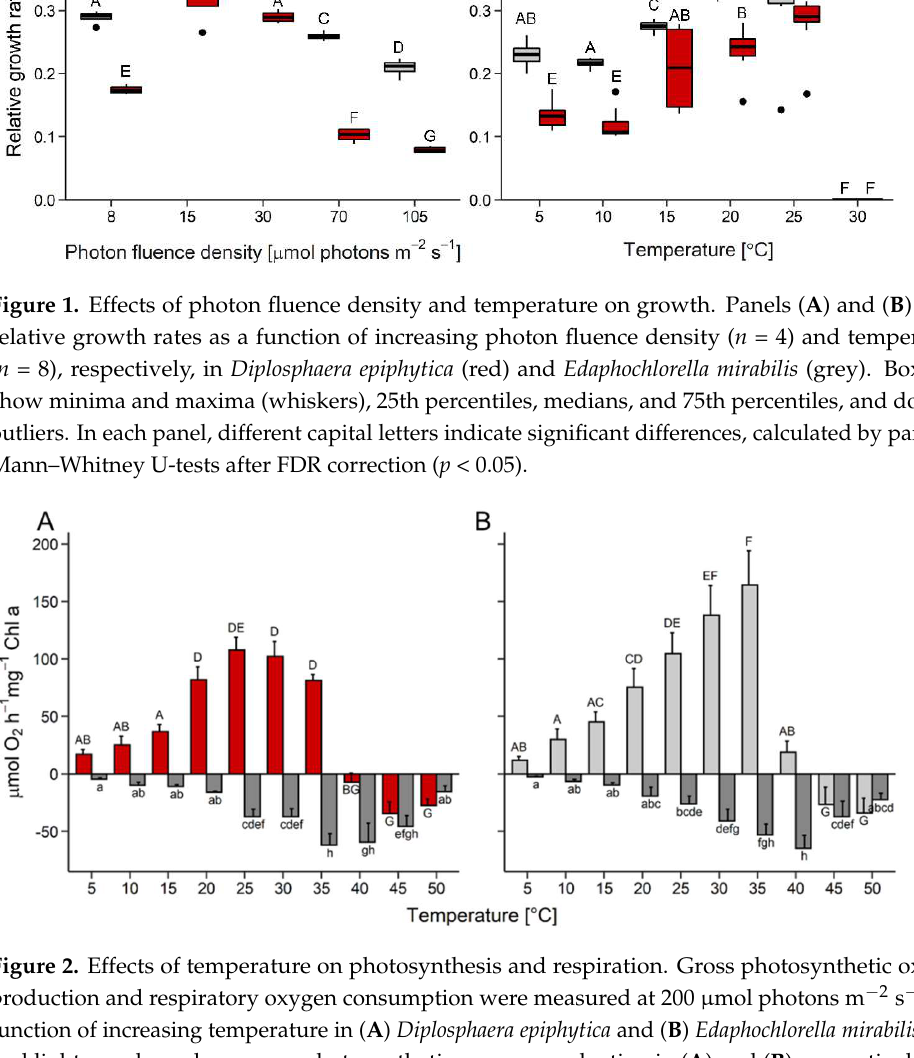
Figure 1. Effects of photon fluence density and temperature on growth. Panels ( A ) and ( B ) show relative growth rates as a function of increasing photon fluence density ( n = 4) and temperature ( n = 8), respectively, in Diplosphaera epiphytica (red) and Edaphochlorella mirabilis (grey). Boxplots show minima and maxima (whiskers), 25th percentiles, medians, and 75th percentiles, and dots are outli- ers. In each panel, different capital letters indicate significant differences, calculated by pairwise Mann–Whitney U-tests after FDR correction ( p < 0.05).